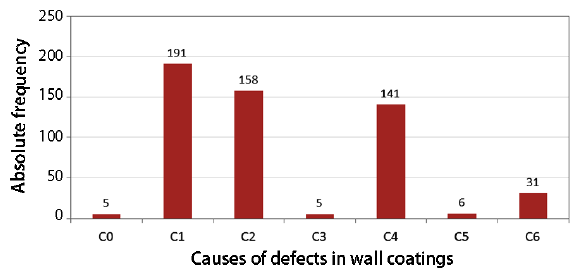
Fig. 25. Absolute frequency of the general groups of causes in wall coatings (10)